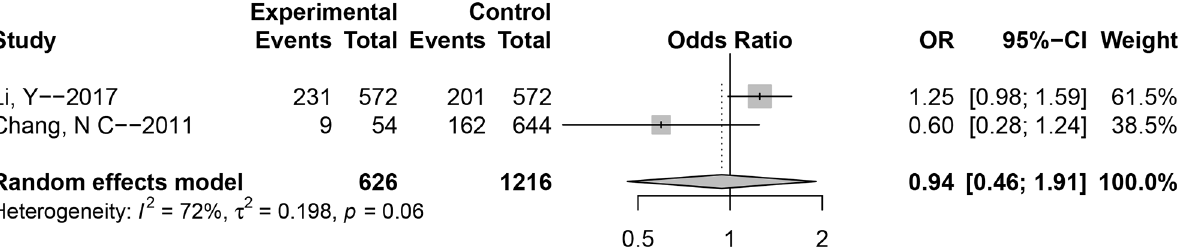
PLOS ONE | https://doi.org/10.1371/journal.pone.0188539 November27,